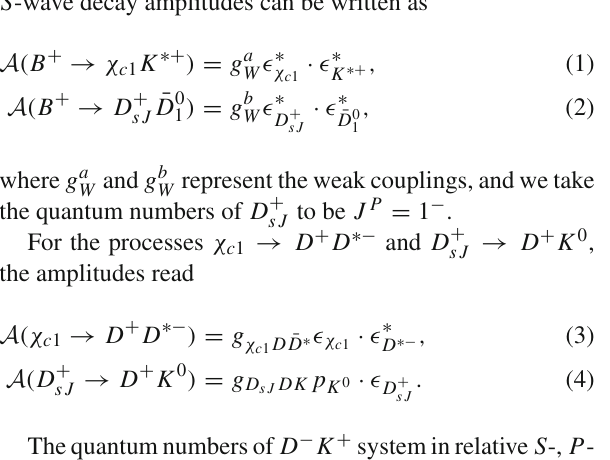
( q ) , D + ( q ) , K 0 ( q 1 2 3 sJ 1